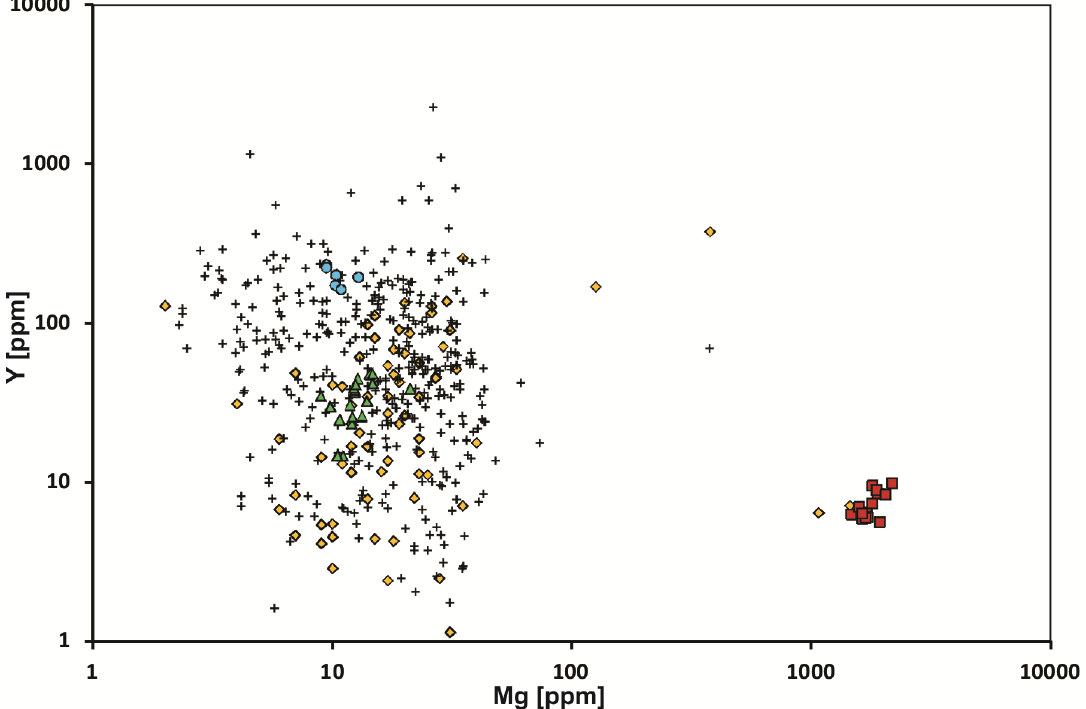
Figure 7. Binary plot of Y and Mg concentrations showing type-1 ferberite is differing significantly from the other groups characterized by high Mg concentration at comparatively low Y levels. Please note that the element concentrations are displayed on the logarithmic scale. Gifurwe = yellow diamonds, Nyakabingo = black crosses, Bugarama: type-1 = red squares, type-2 = green triangles and type-3 = blue circles.